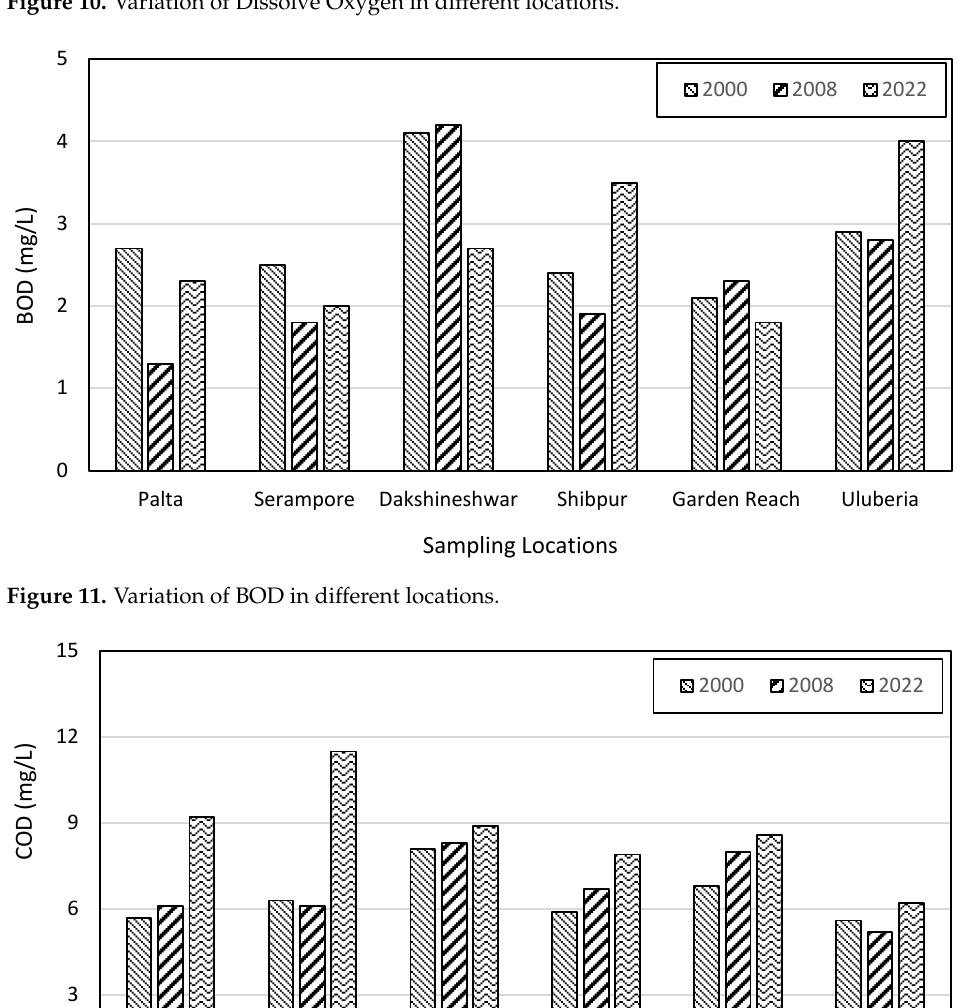
Figure 10. Variation of Dissolve Oxygen in different locations.